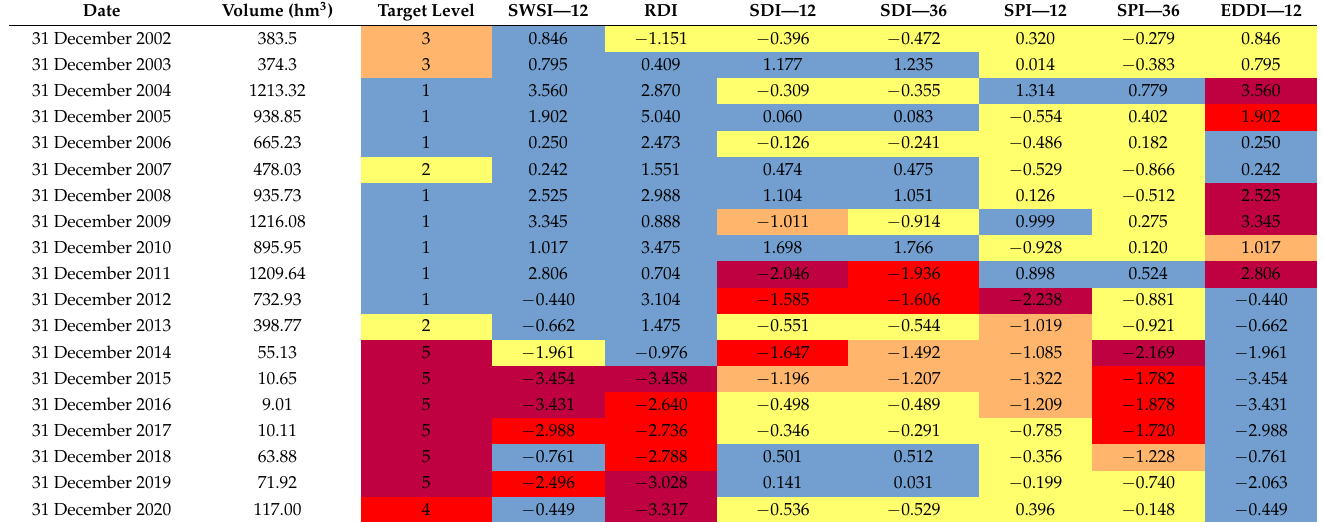
Table 10. Analysis of the indexes in relation to the Target Levels for the Banabui ú reservoir.